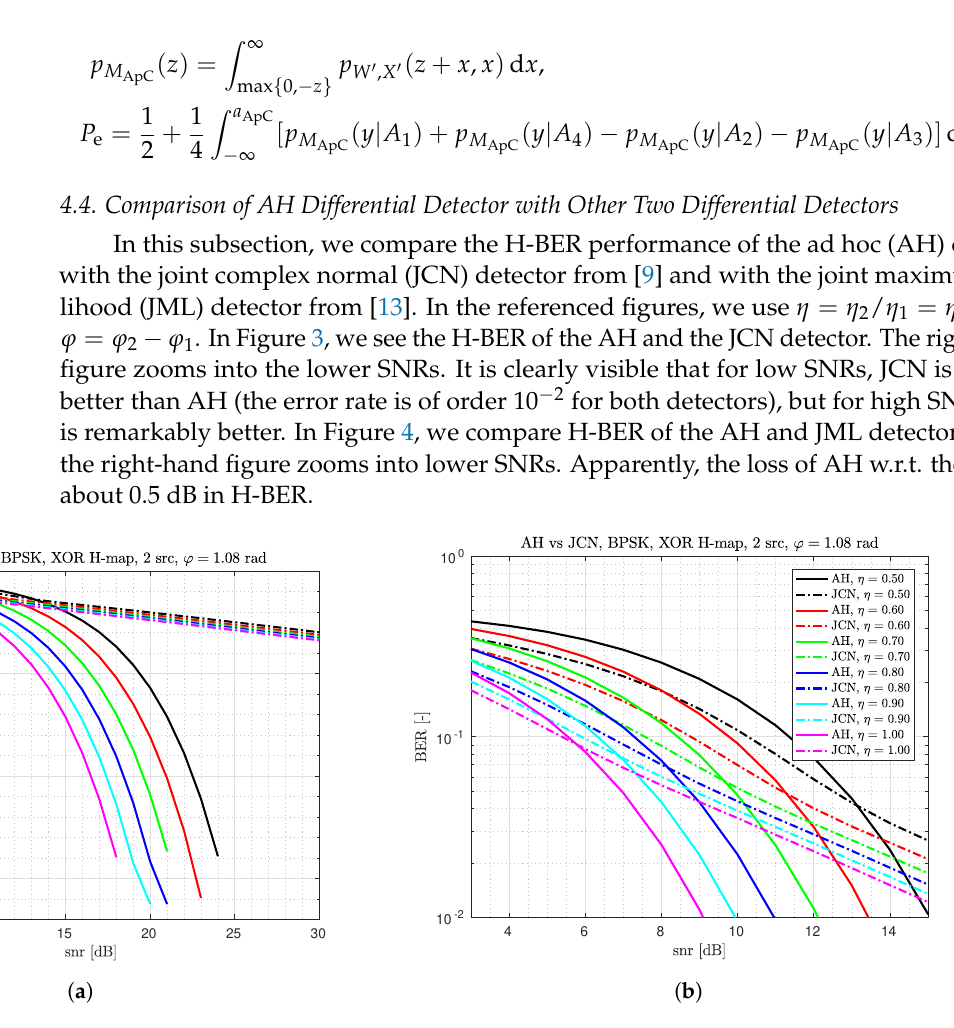
Figure 3. H-BER of ad hoc (AH) vs. JCN detector for different ranges of SNR. ( a ) Ad hoc (AH) vs. JCN detector for SNR from 3 dB to 30 dB. ( b ) Ad hoc (AH) vs. JCN detector for SNR from 3 dB to 15 dB.